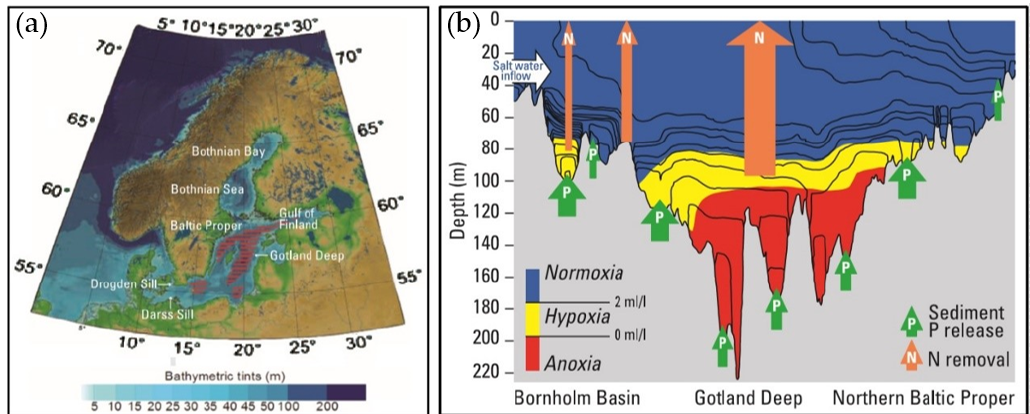
Figure 1. ( a ) Map of the Baltic Sea. ( b ) Vertical distribution of hypoxia in the Baltic Sea [36].